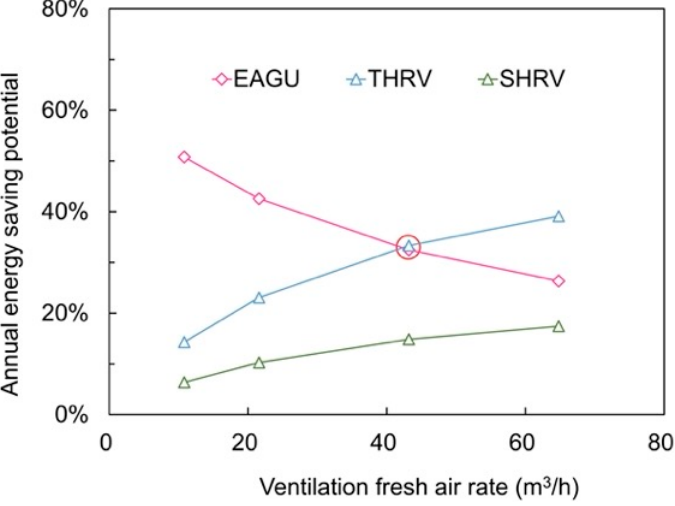
Figure 13. Effect of ventilation fresh air rate on the energy saving potential of different exhaust air heat recovery units in the HSCW climate.